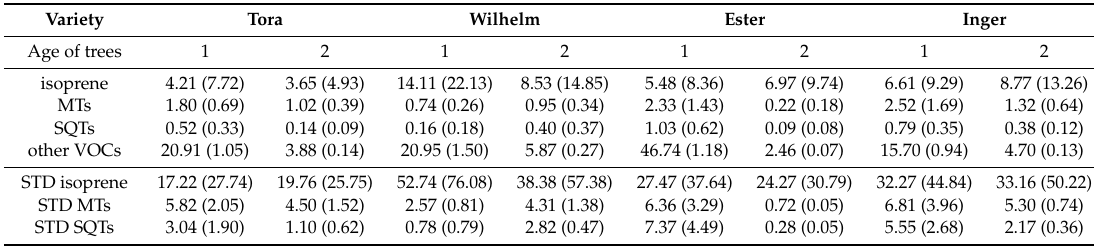
Table 8. Upper part: Measured emission rates ( µ g g dw − 1 h − 1 , mean ± standard deviation, n = 24–77) for isoprene, MTs, SQTs and other VOCs for the di ff erent Salix varieties and ages. Lower part: